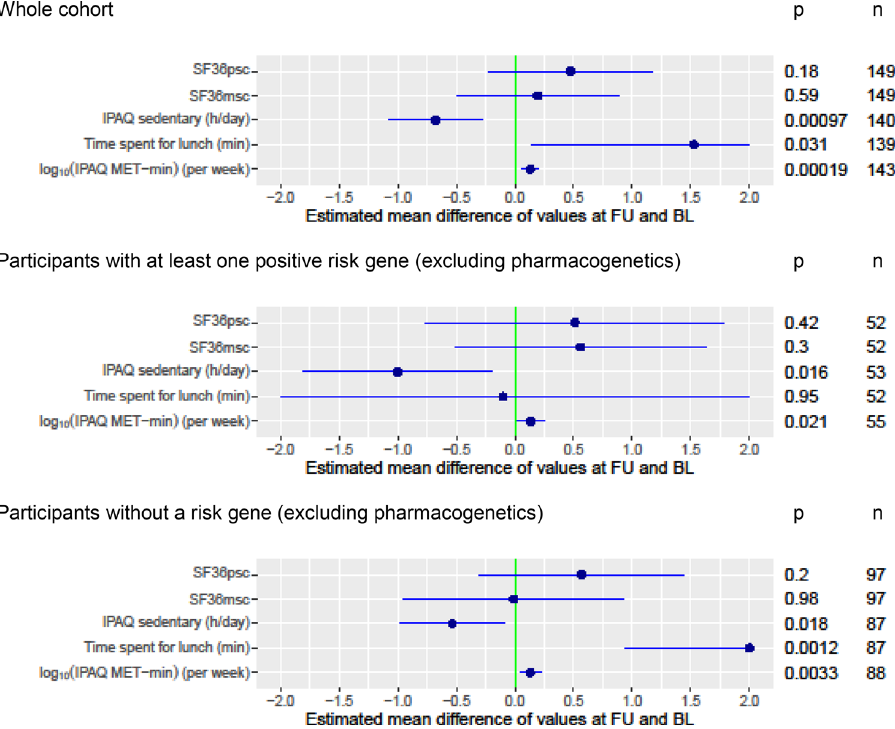
Figure 3. Subgroup analysis of differences in outcome measures between follow-up and baseline. Dots = estimated mean difference after adjusting for age, gender, and body mass index, whiskers = 95% confidence interval, clipped when exceeding the displayed range, X-axis: the estimated mean difference between follow-up and baseline (FU-BL), except for IPAQ MET-min, where we consider the difference of logarithmized values. BL baseline, FU follow-up, h hour, IPAQ International Physical Activity Questionnaire, MET-min metabolic equivalent of task per minute, min minute, n number, p raw p-values, SF36msc mental health subscale of the Short-Form Health Survey, SF36psc physical health subscale of the Short-Form Health Survey. Graph was created with R 12